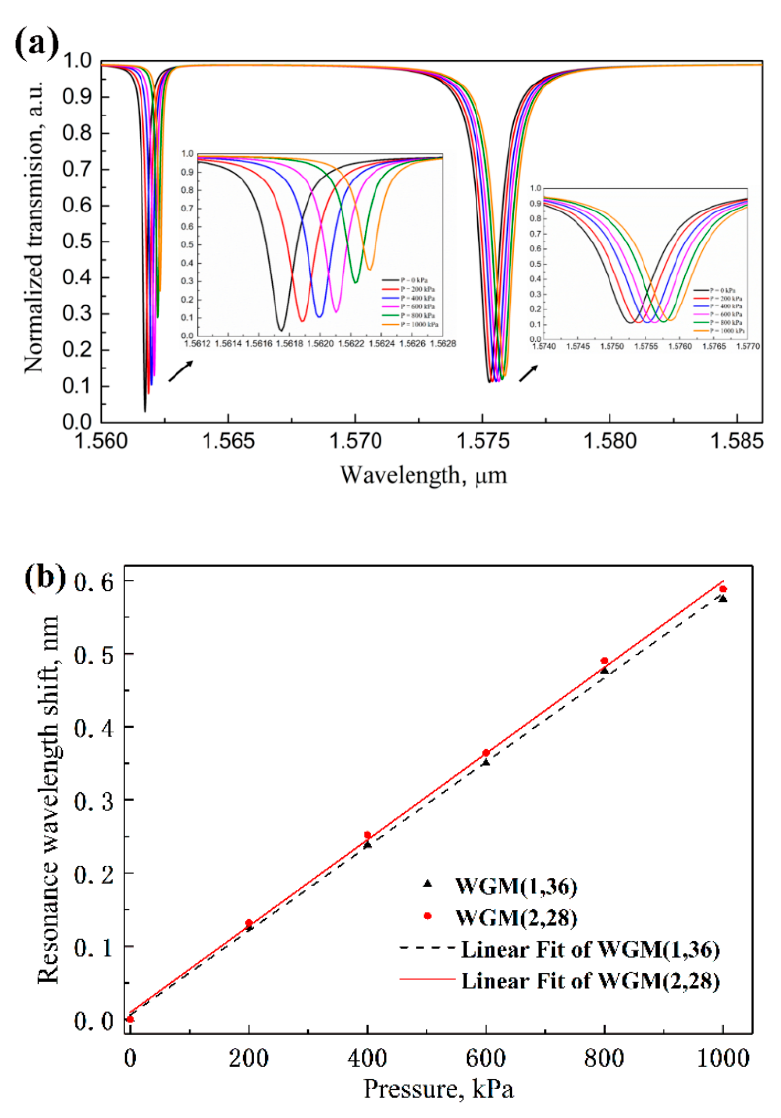
Figure 10. ( a ) The transmission spectra with different pressure ranging from 0 to 1000 kPa in a step of 200. ( b ) The linear fit of resonance wavelength shifts of the MDR versus the applied pressure .